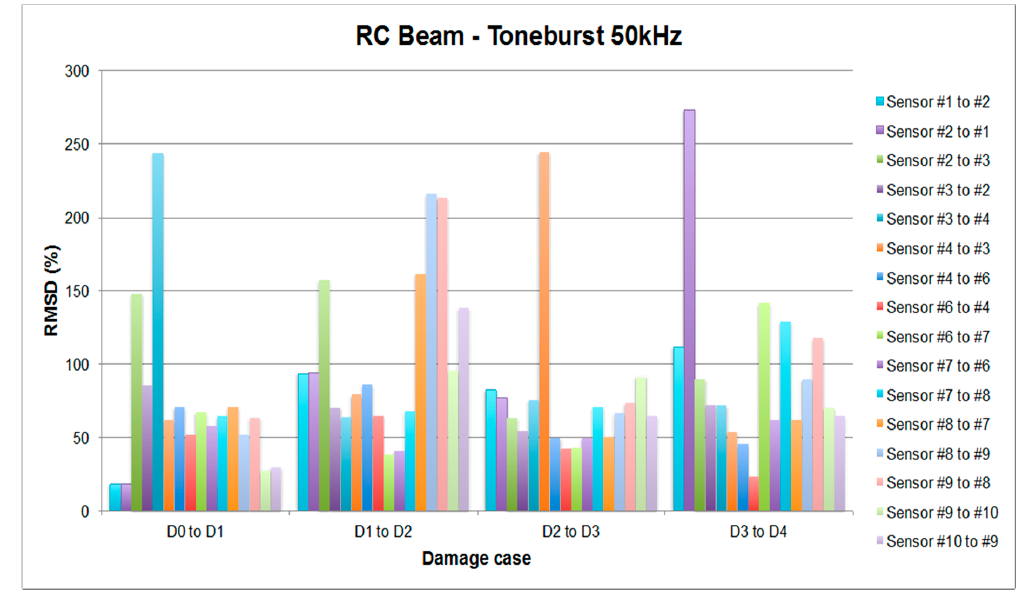
Figure 29. RMSD values for the RC beam.